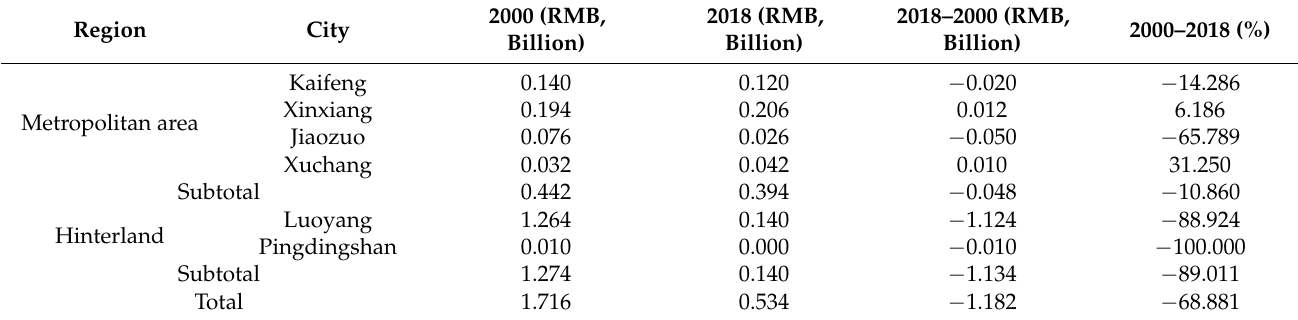
Table 7. The ESV spatial transfer amount into Zhengzhou and its change from 2000 to 2018.